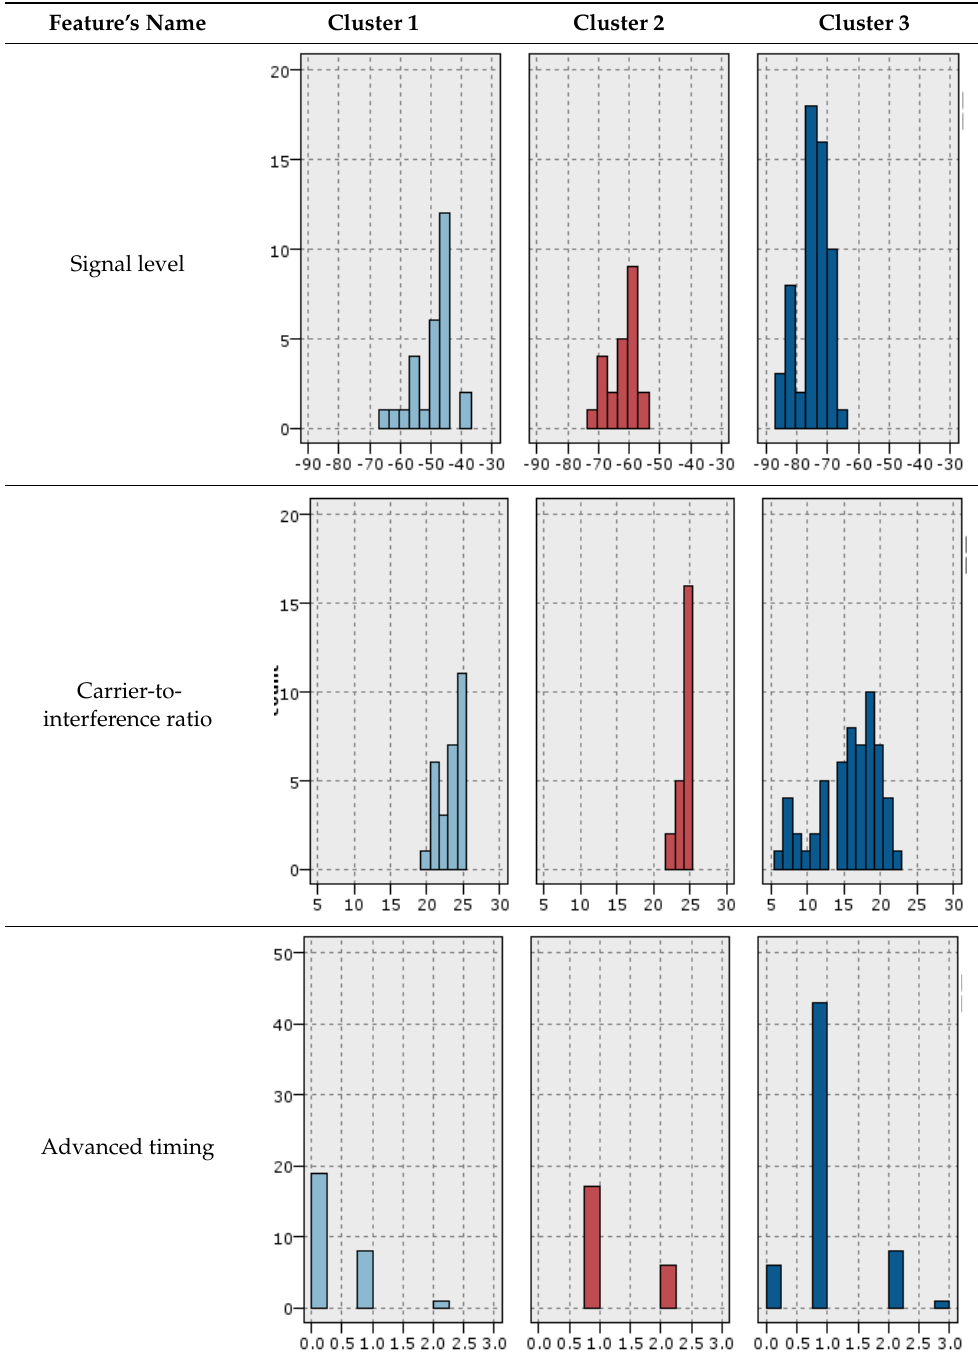
Table 6. The details of Clusters and Feature’s name.